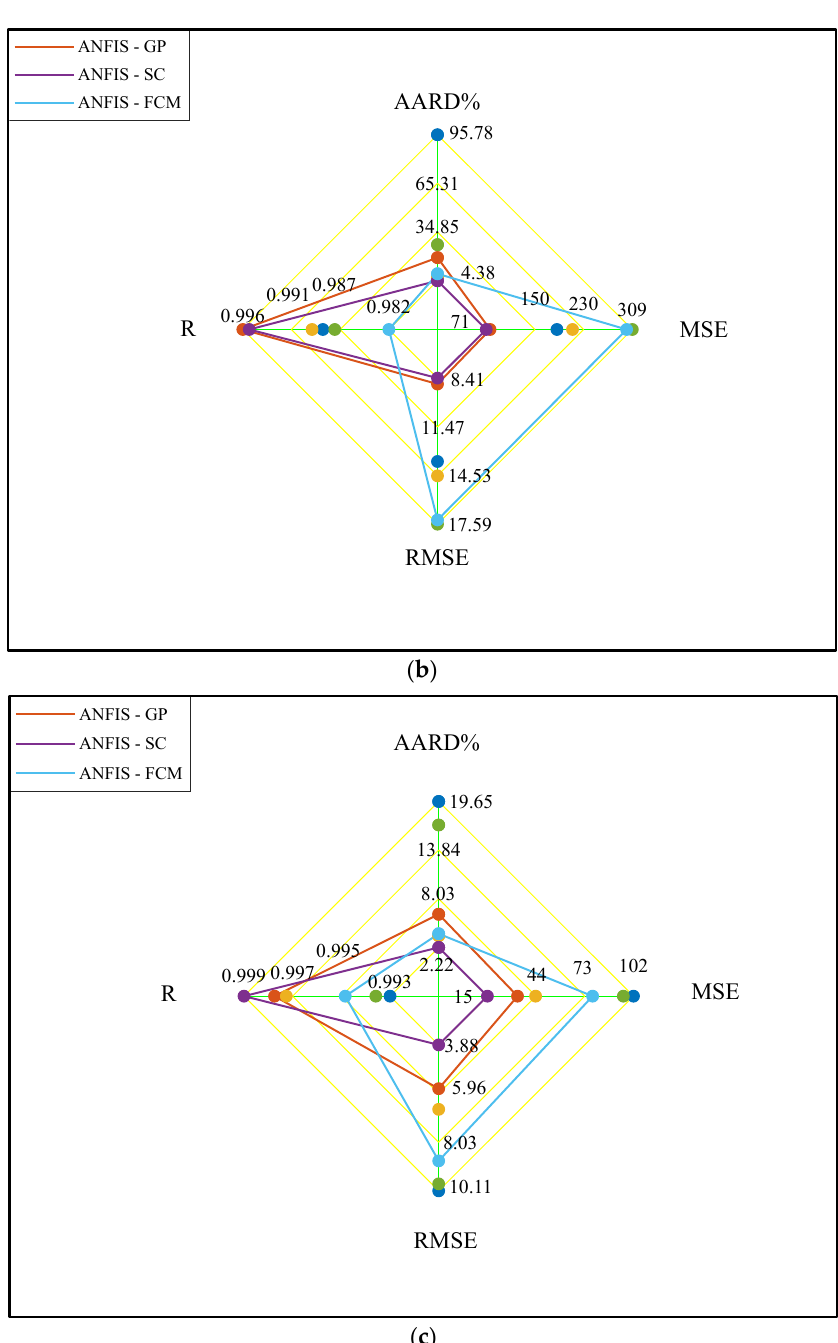
Figure 2. Spider plot for comparing the ANFIS models’ performance in the ( a ) training, ( b ) testing, and ( c ) all of the database.